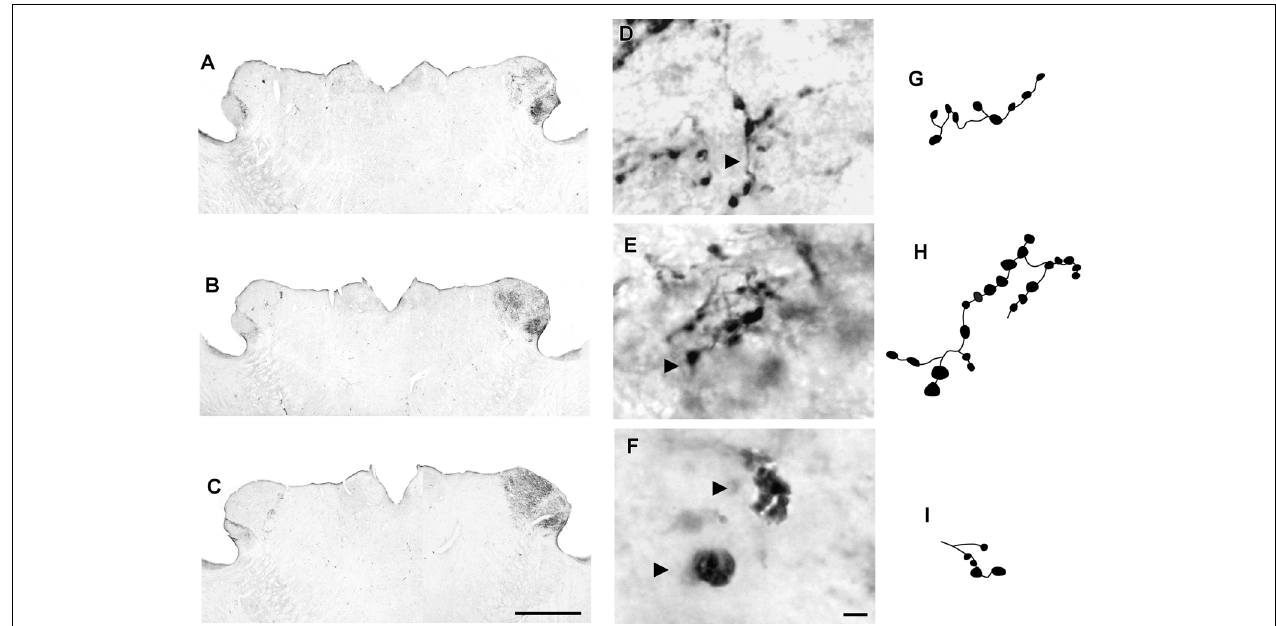
FIGURE 7 | Photomicrographs of the lateral geniculate complex coronal sections of the flat-faced fruit-eating bat at rostral (A) , middle (B) and caudal (C) levels, illustrating the distribution pattern of retinal projections in the ipsi and contralateral sides. The boxed areas in (A–C) are shown in high magnification in (D–F) , respectively, illustrating the detailed morphology of the retinal axons in the IGL showing cholera toxin-labeled varicosities in the simple endings (D) , string-like terminals (E) and R2-like terminals (F) . Black arrowheads point to sort of fibers. (G–I) Camera-lucida drawings that depict the morphology of simple endings (G) ; string-like terminals (H) and R2-like terminals (I) . Scale bar 500 µ m (A–C) and 10 µ m (D–I)